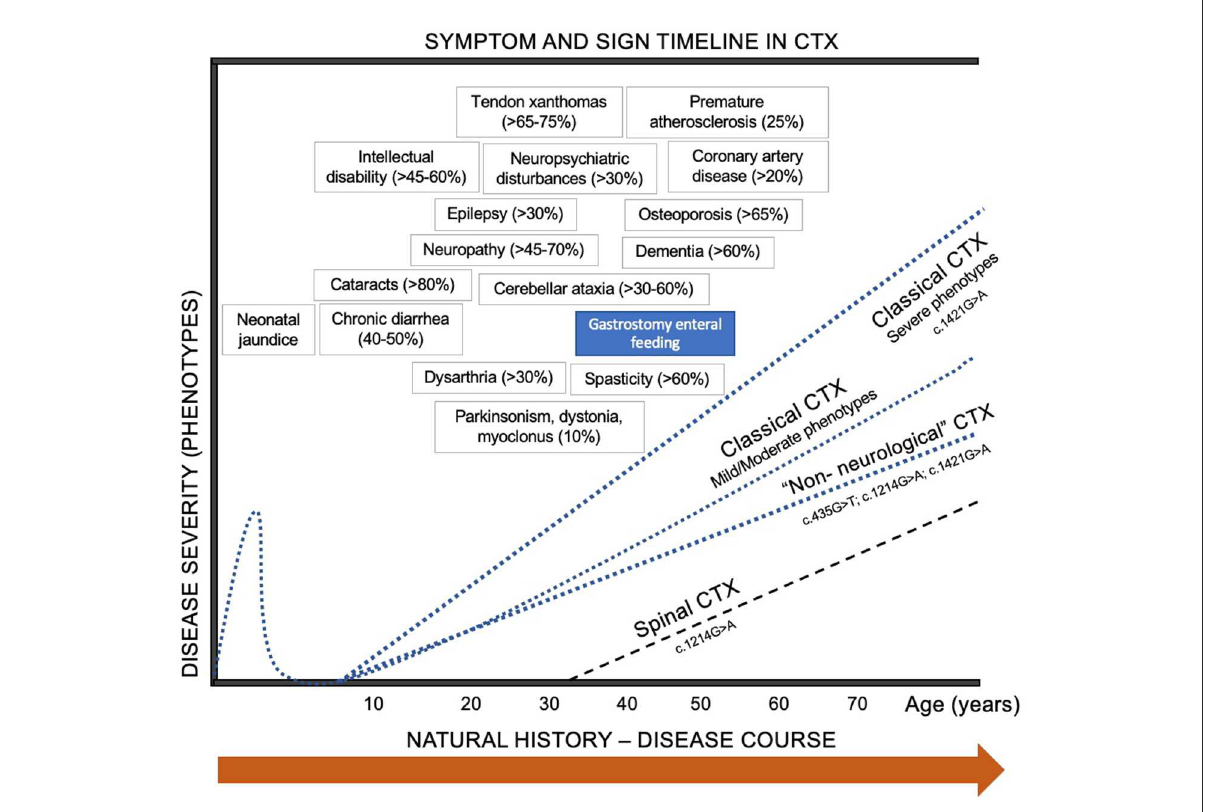
FIGURE1 Biochemical pathways of bile acid metabolism and pathophysiological mechanisms involved in CTX. Both alternative (acidic) and classic (neutral) pathways in liver metabolism are represented in blue color. Primary bile acids (Cholic acid and Chenodeoxycholic acid) are represented in orange. Secondary and tertiary bile salts are showed in red. Brain neurometabolic steps are represented in black squares, as well as molecular targets (receptors) of CDCA and CA (1, 9,